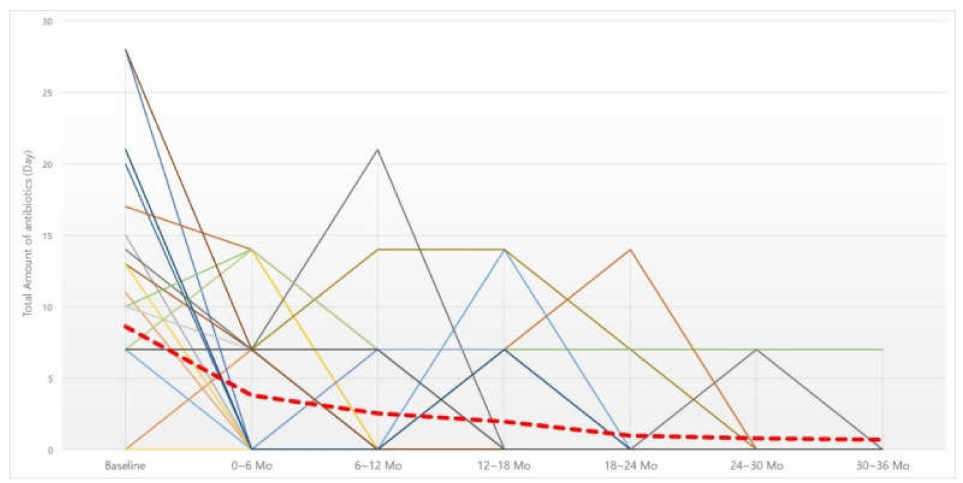
Figure 2. Changes in 6-month dosage of oral antibiotics. Red dotted line, average of oral antibiotics intake (day). Abbreviation: Mo,